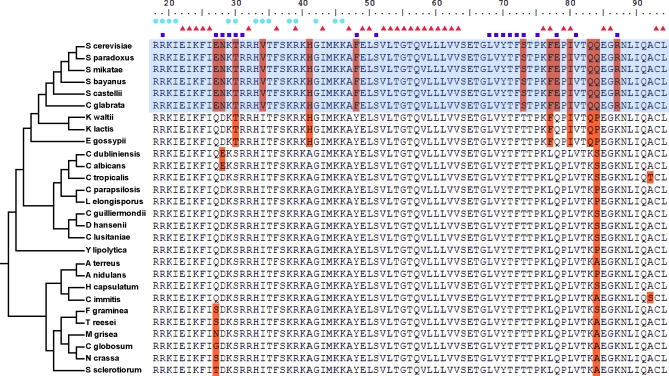
Substitutions within the MADS Box Domain of Mcm1There are a few substitutions to the MADS box domain of Mcm1 (orange) against a background of strong conservation (white) within the hemiascomycete and euascomycete lineages. The shaded box indicates Mcm1 orthologs from species that also have an Mcm1 duplicate (named Arg80 in S. cerevisiae). Mcm1 residues forming contacts with α2, Mcm1, or DNA in the crystal structure of the α2-Mcm1-DNA ternary complex (Protein Databank ID: 1mnm) are indicated above the alignment with squares, triangles, and circles, respectively. Note the strong correlation between those species having substitutions at the α2 interacting residues, those species with an Mcm1 duplicate, and those species thought to be using a purely negative mode of asg regulation by Mcm1 and α2[24].